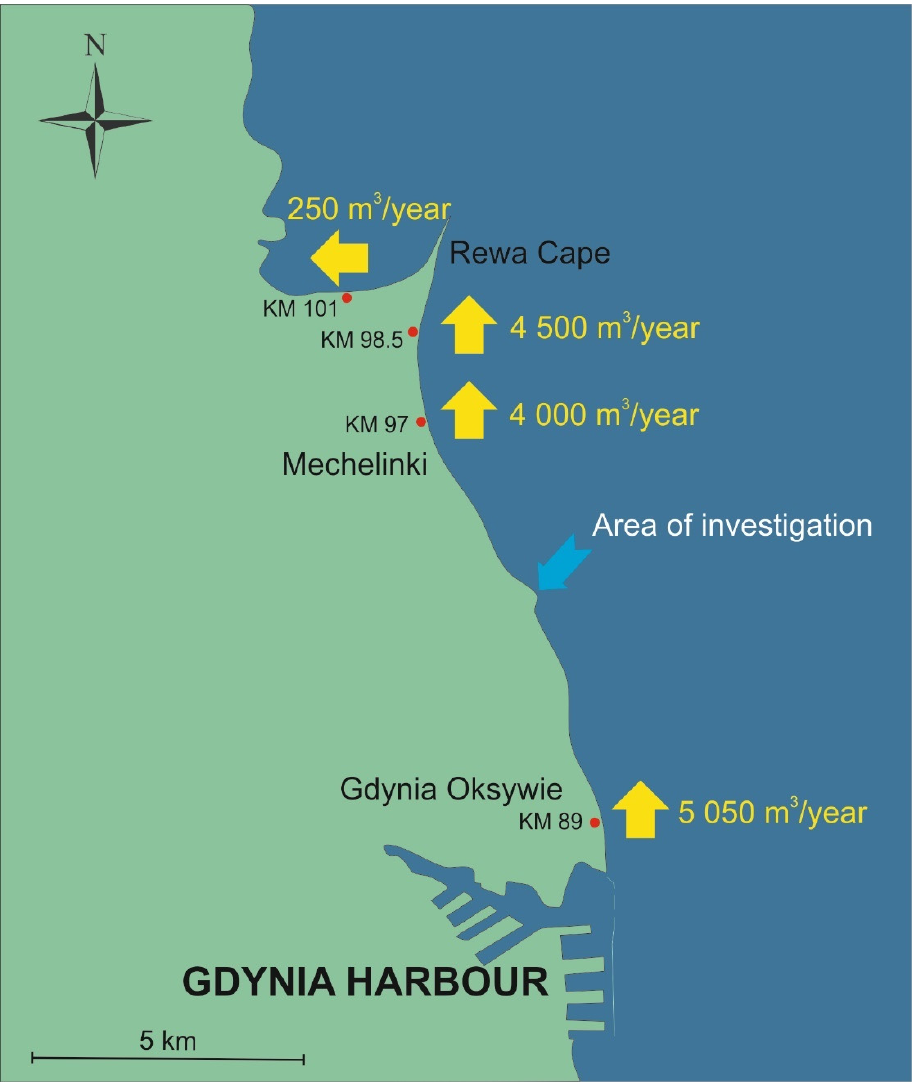
Figure 6. Directions and approximate volumes of mean annual longshore sediment transport. The blue arrow indicates the approximate location of KM 93.6–93.9 [10].